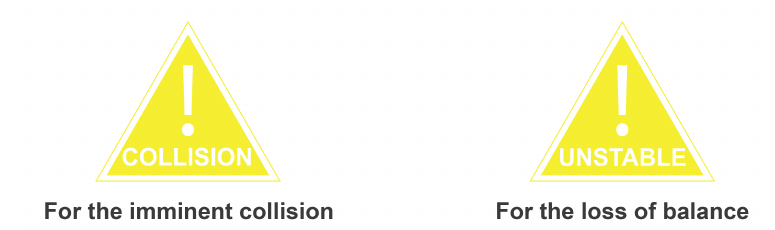
Figure 18. Two kinds of the warning sign. The left one is for when a collision is imminent to occur and the right one is for when the machine is about to tip